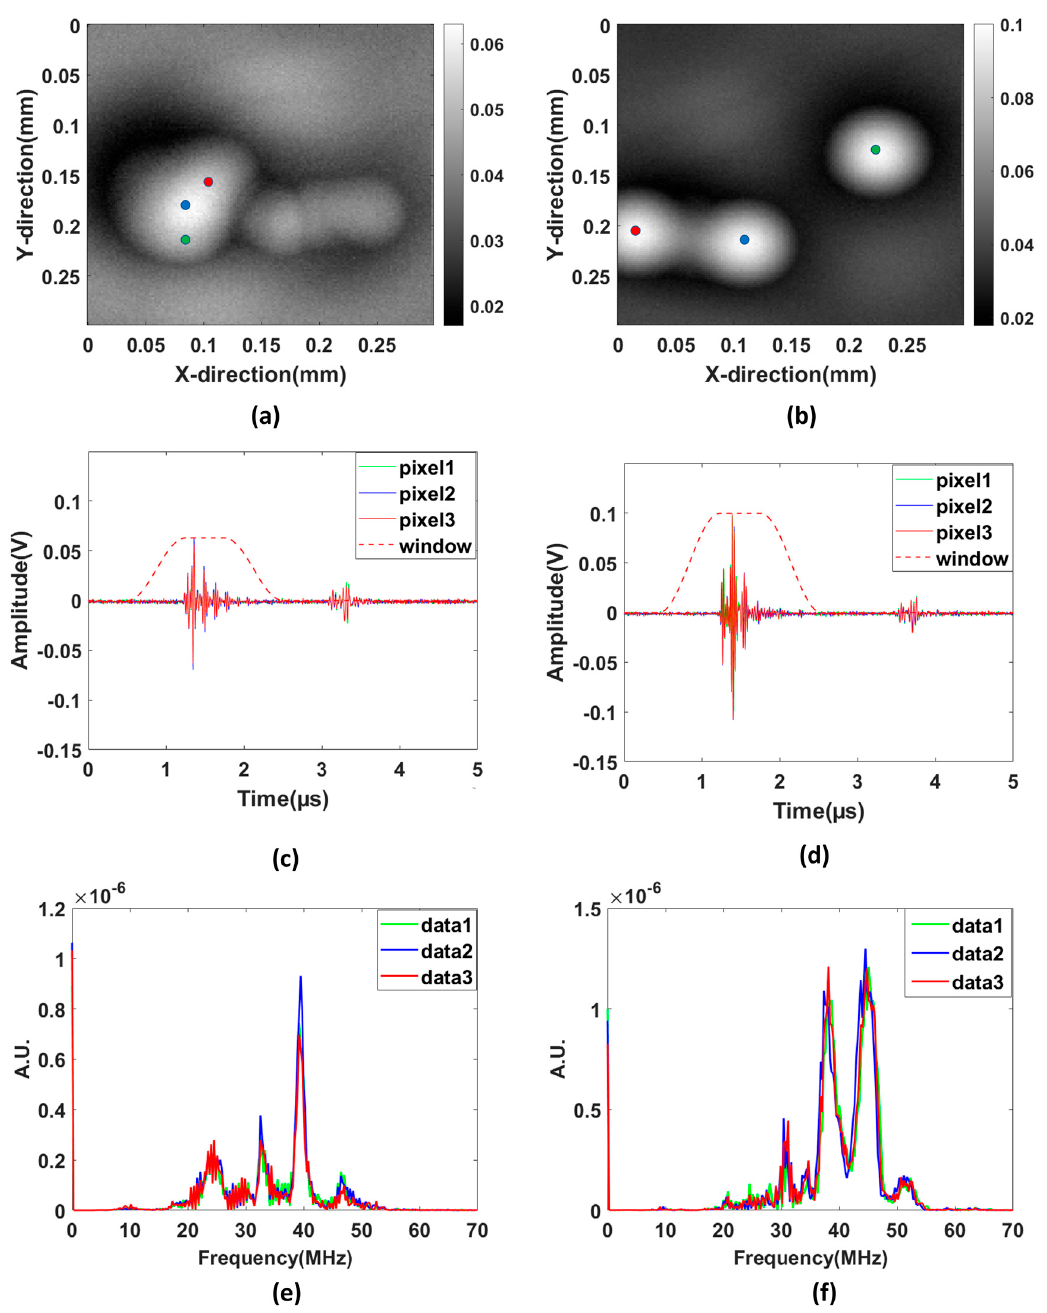
Figure 4. Experimental results for scanning acoustic imaging. Here, the upper images show the maximum amplitudes obtained for the 2 particle sizes ( a ) PS40 ( b ) PS80 over the entire scanning area. Time series for pixels close to the center of two particles in each image (marked with red, green, and blue dots) are shown with corresponding colors in ( c , d ) and for PS40 and PS80, respectively. The amplitude spectra corresponding to the time series in ( c , d ) are shown in ( e , f ) respectively.